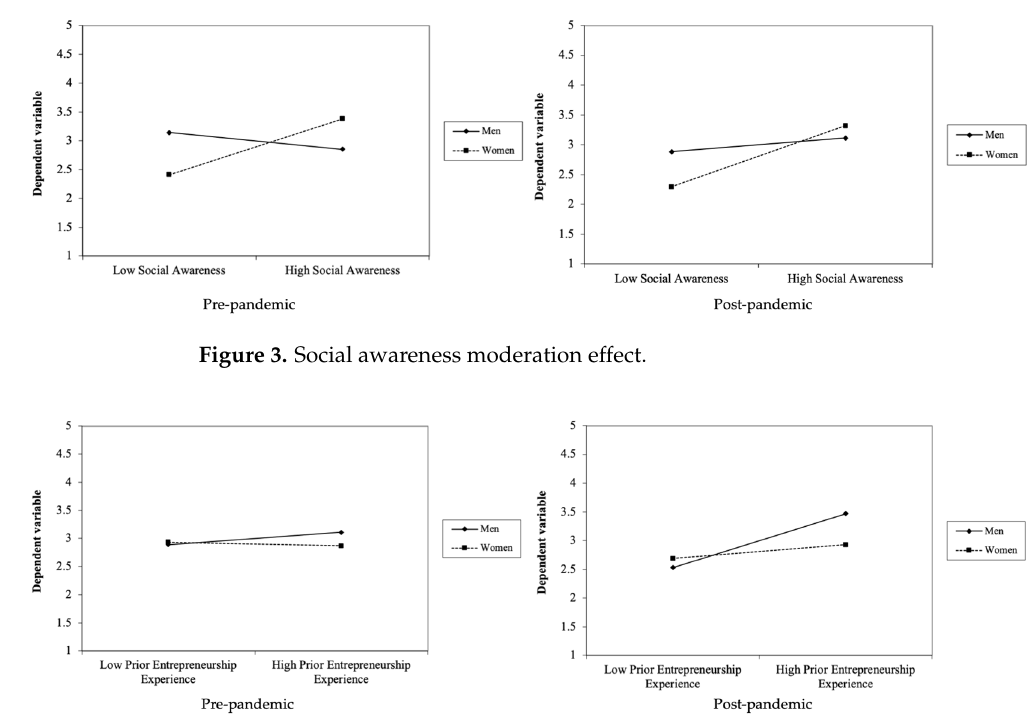
Figure 4 . Prior entrepreneurship experience moderation effect.